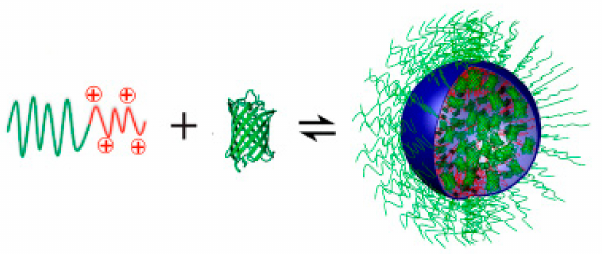
Scheme 5. Graphical representation of protein–block polyelectrolyte micelle formation utilizing green fluorescent protein. Reprinted with permission from Ref. [85]. Copyright 2015, American Chemical